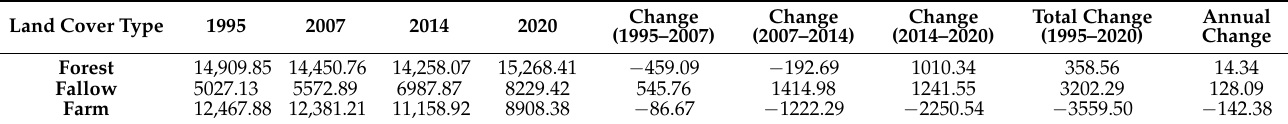
Figure 2. Land cover map for the years 1995, 2007, 2014, and 2020. Table 5. Land cover area, change, and annual rate of change (ha) for the study landscape, 1995–2020.